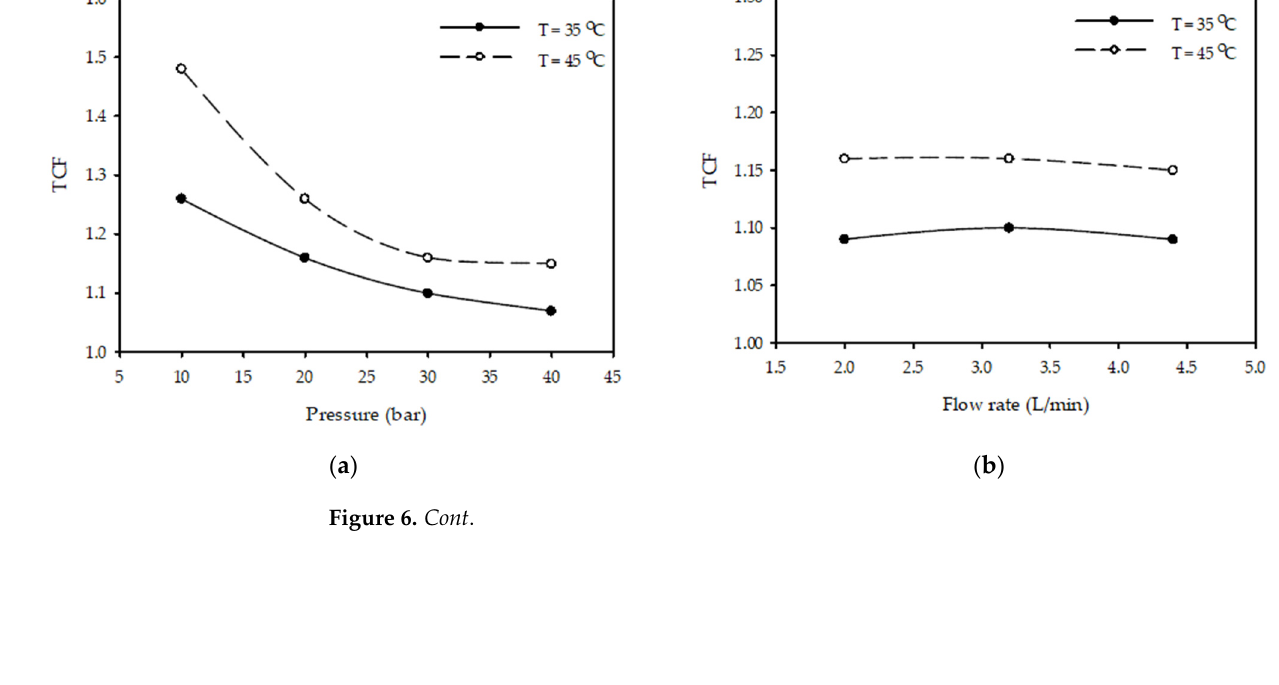
( c ) Figure 6. Effect of ( a ) pressure at (3.2 L/min, 100 ppm) ( b ) flow rate at (30 bar, 100 ppm) ( c ) feed concentration at (20 bar, 3.2 L/min) on TCF at different temperatures. 3.6. Mathematical Model Mathematical models were thus developed based on the data collected from the experiments. Two mathematical models will be developed, one for the permeate flux and another for the copper removal percentage. The four parameters, concentration, temper- ature, pressure and flow, will be included in the mathematical model. 3.6.1. Permeate Flux Model In this model, an assumption that the parameters independently affect the permeate flux and thus superposition holds, i.e., 𝑓𝑙𝑢𝑥 = 𝑓(𝑇) + 𝑔(𝑃) + ℎ(𝐶) + 𝑚(𝐹) (4) where f ( T ), g ( P ), h ( C ), and m ( F ) are functions of temperature, pressure, concentration, and flow, respectively. With this model, changing one parameter while keeping all the others fixed will result in a similar response as observed in Figures 2a, 3a, 4a and 5a. In these figures, changing one parameter (concentration or flow) results in similar but shifted